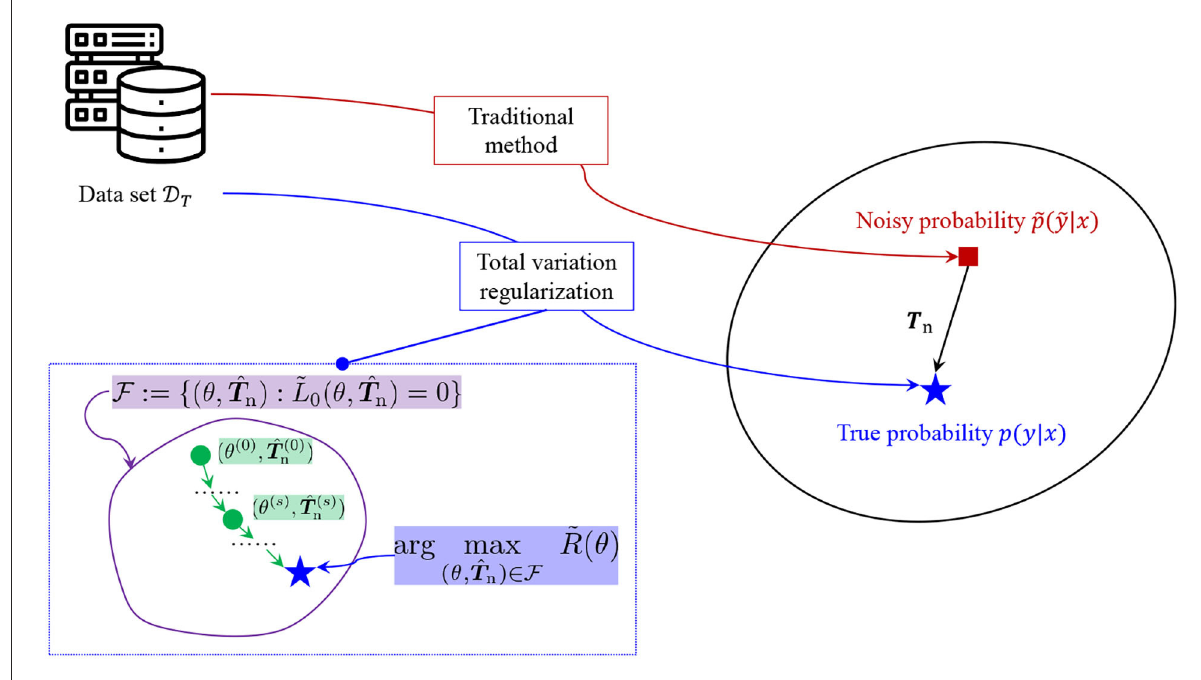
FIGURE2 Concept of estimating the transition matrix and the probability